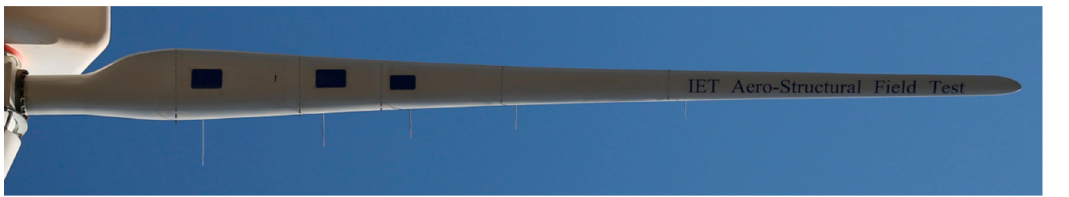
Figure 6. Photo of the tested blade.